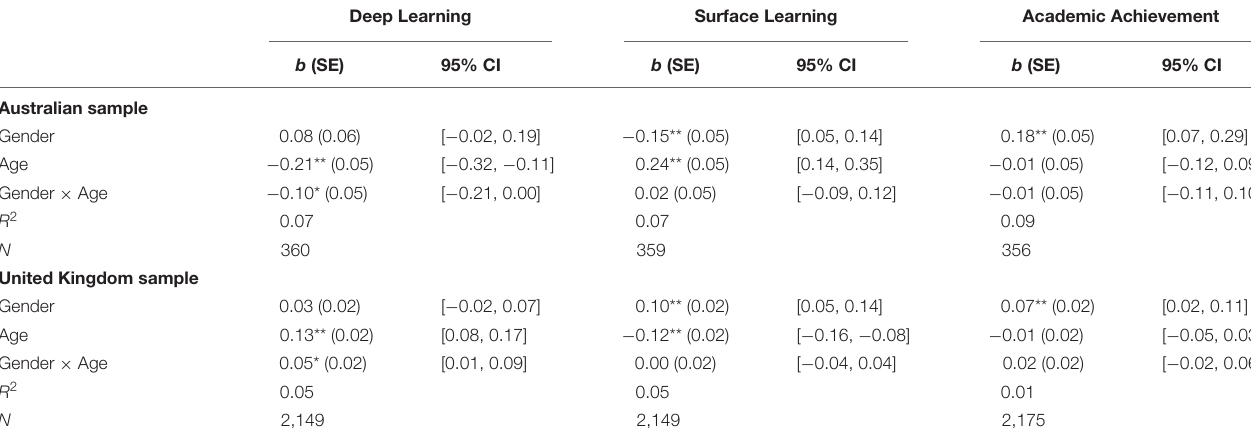
TABLE 2 | Gender, age, and their interaction as predictors of learning approach, degree satisfaction, and academic achievement. Deep Learning Surface